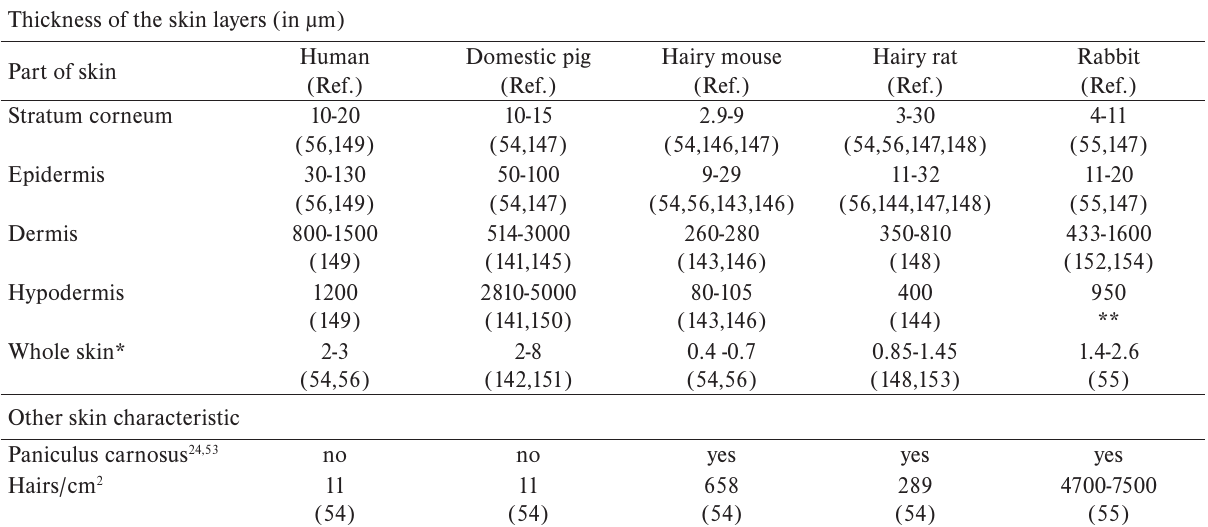
Table 1. Comparison of skin composition between human, domestic pig, hairy mouse, hairy rat and rabbit 24,53-56,141-154 . Thickness of the skin layers (in μm) Part of skin